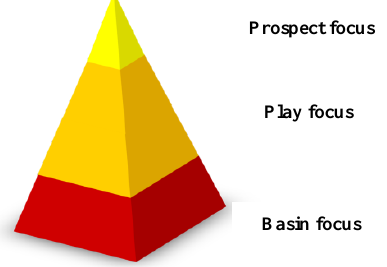
Figure 2. PBE Pyramid (Royal Dutch Shell, 2014)